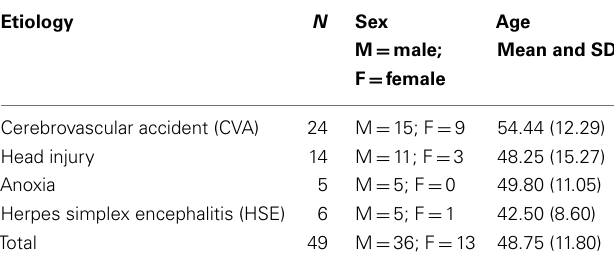
Table 1 | Patients’ demographic characteristics and cause of brain injury .